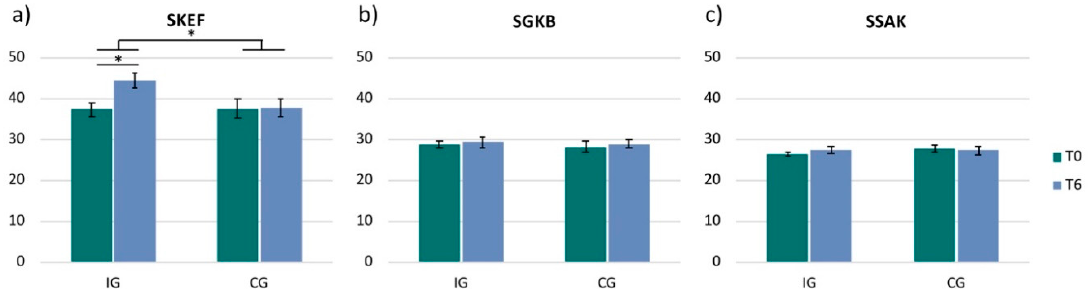
Figure 3. Frankfurt Body-Concept Scales. Bar plots show the 3 dimensions of the questionnaire for each group (IG = intervention group and CG = control group) and for each timepoint (T0 and T6): ( a ) ‘physical efficacy’ (SKEF); ( b ) ‘health’ (SGKB); ( c ) ‘self-acceptance of one’s body’ (SSAK); p <